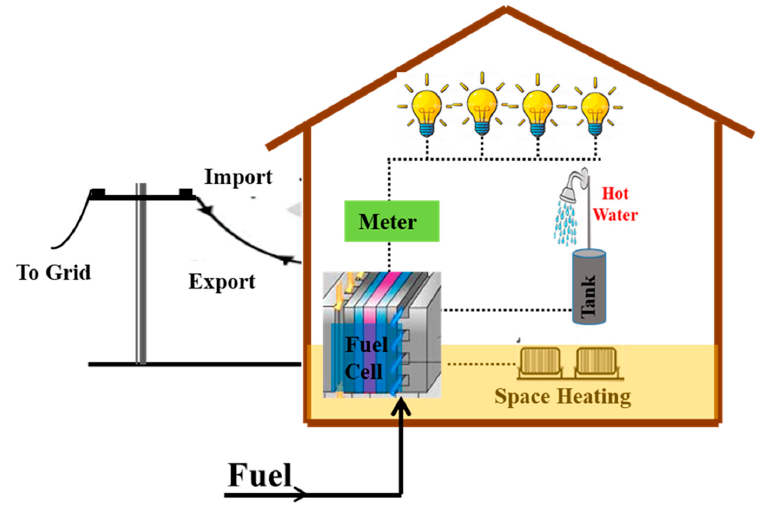
Figure 4. Fuel cell micro combined heat and power (CHP) for importing and exporting electricity.